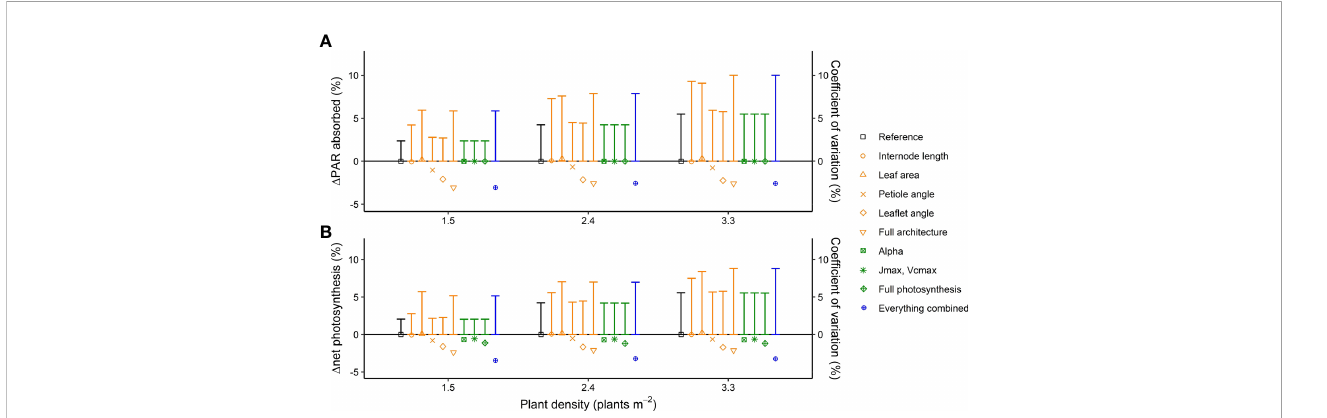
FIGURE 3 Simulated effects of interplant variation in architectural and photosynthesis traits on (A) canopy light absorption (symbols) and the coef fi cient of variation in plant light absorption (vertical bars) and (B) net photosynthesis (symbols) and the coef fi cient of variation in photosynthesis (vertical bars) at three planting densities. Canopy light absorption and plant net photosynthesis are presented as % change compared to the reference where the rotation of plants relative to their neighbors (0 to 360 ◦ , drawn at random) was the only source of variation. The rotation of the plants relative to their neighbors was kept the same for every model simulation such that any differences in light absorption and net photosynthesis are the result of including interplant variation of architectural and/or photosynthesis traits. Data are the averaged values of all hourly time steps in a day of 24 plants (centre 12 plants of the centre two double rows) from fi ve repetitions (simulations with each a different random number generator for the light model and drawings from the normal distribution), at two fractions of direct light (0 and 0.77) and two solstices summer and winter (DOY 171 and 356), resulting in a total of 480